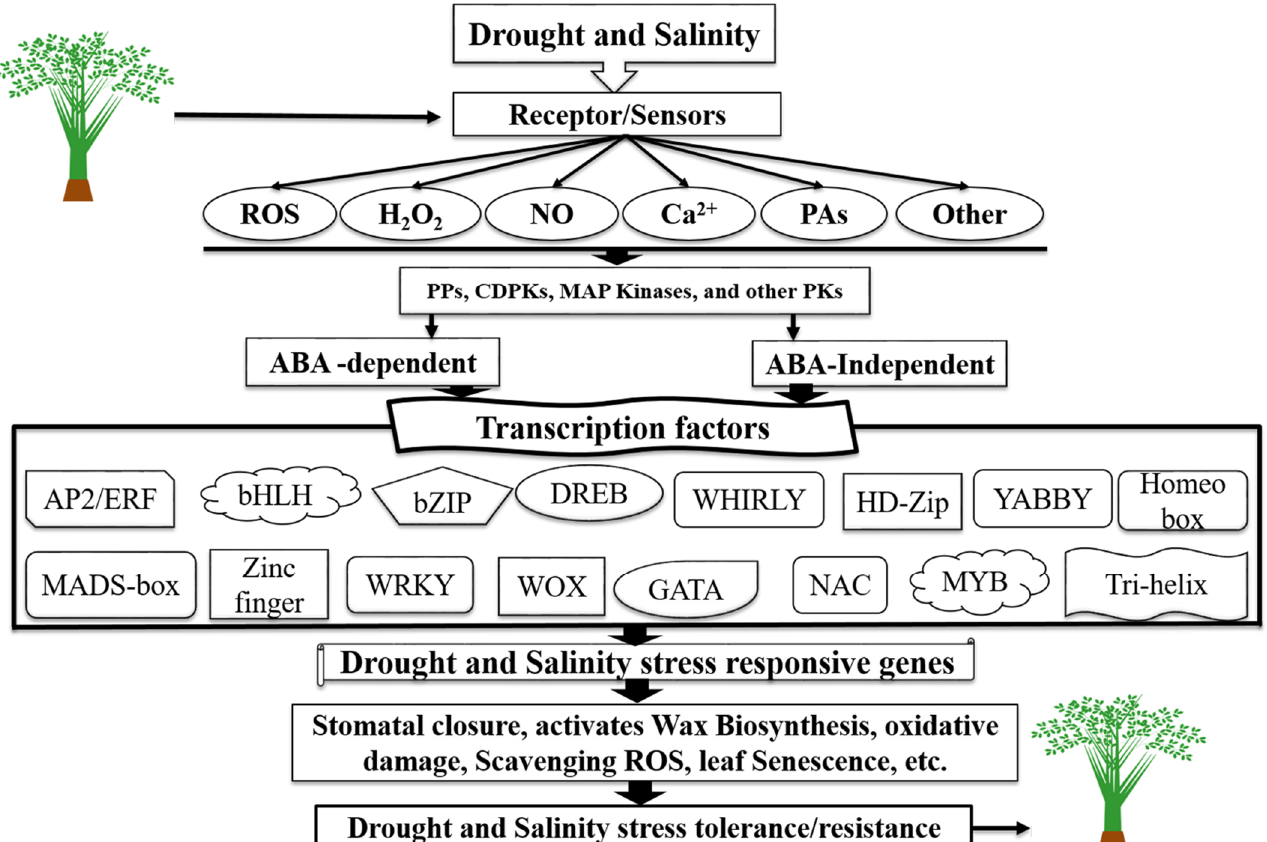
Figure 1. Schematic diagram of TFs as key components in transcriptional regulatory networks during drought and salinity stress-signaling pathways in different crops/plants. A diagrammatic representation of gene expression and drought and salinity stress signal perception in plants via ABA-independent and ABA-dependent pathways (modified from Khan et al. [34]).